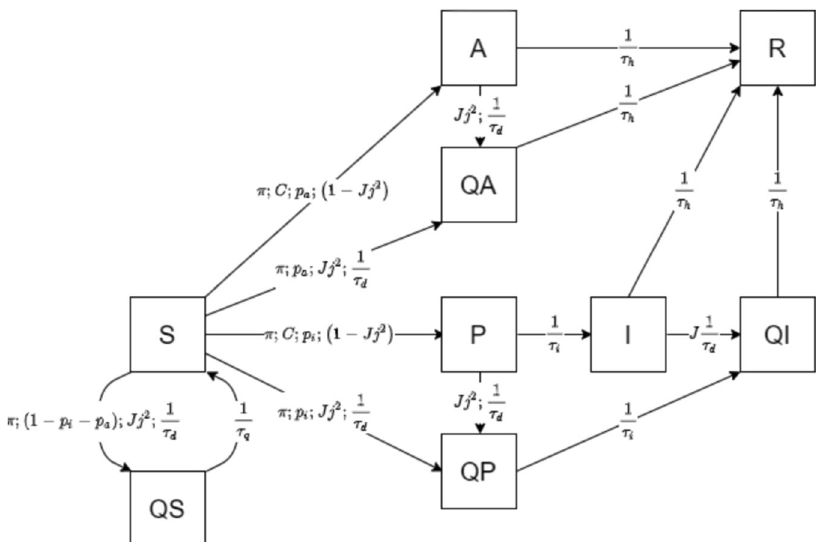
Fig. 2 Model outline. Graphical representation of the interactions among the different compartments of the extended SIR model. S susceptible, I infected, R recovered, A asymptomatic, P pre-symptomatic, QS quarantined susceptible, QI quarantined infected, QA quarantined asymptomatic, QP quarantined pre-symptomatic. Rates of transfer between compartments are a function of the parameters annotated on the arrows. A detailed description of such parameters is provided in “ Methods ” and Table